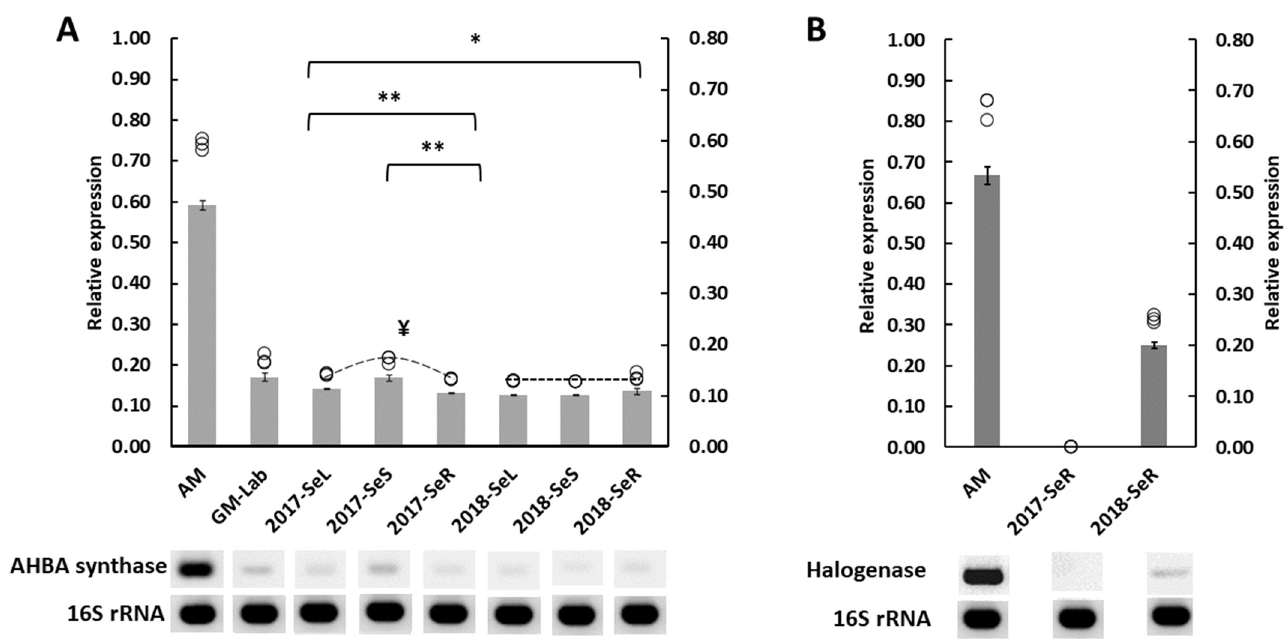
Figure 6. Maytansine’s biosynthetic genes expression. AHBA synthase gene expression is presented on the left ( A ), while halogenase gene expression is shown on the right ( B ). The relative gene expression is exhibited in the mean ± SD of triplicated samples (n = 3). AM indicates A. mirum (DSM 43827) as a reference. GH-Lab indicated G. heterophylla cultivated in our laboratory, Germany. 2017-SeL, 2017-SeS, and 2017-SeR indicate the leaves, stems, and roots parts of the 2017 collection of G. heterophylla originated from South Africa, while 2018-SeL, 2018-SeS, and 2018-SeR indicate the counterpart from the 2018 collection. Additionally, 16S rRNA is used as a housekeeping gene. The bar graph uses the x -axis on the right side while O indicates each sample data point, using the x -axis of the left side. * indicates the statistic significant by student t -test (one-tail) with p -value ≤ 0.05. ** indicates the statistic significant by one-way ANOVA with p -value ≤ 0.05. ¥ indicates the highest AHBA synthase gene expression.